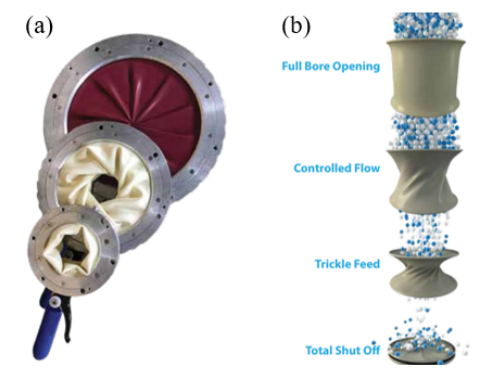
Figure 3. Iris valves. ( a ) Different sizes of iris valve. ( b ) The folding process of iris valve sleeves. (Images from https://www.mucon.com/ (access on 25 August